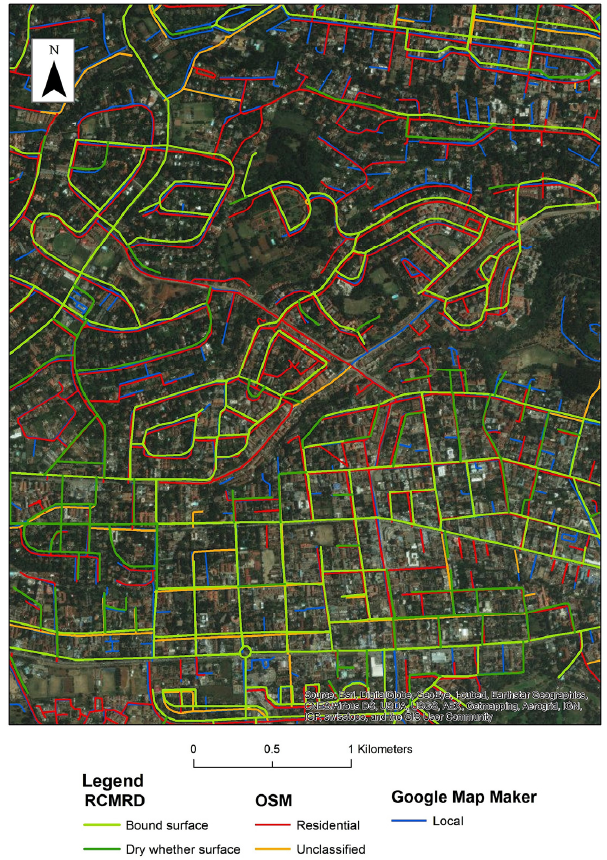
Figure 2. Spatial distribution of road types from different sources for a residential settlement in western Nairobi (background imagery source: ESRI [80]).